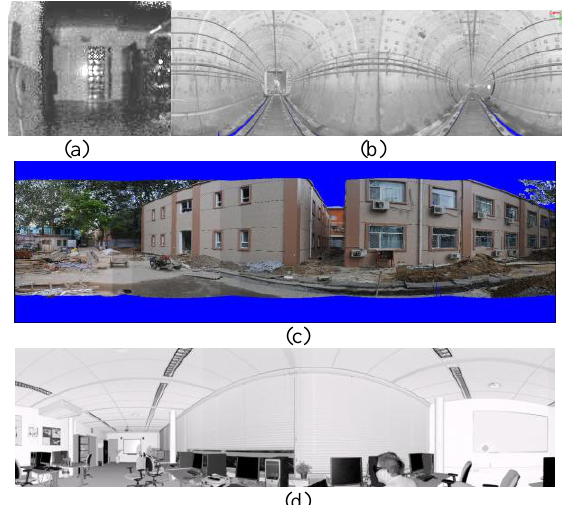
Figure 2. Experimental datasets visualized as panoramic 2D images. The grey values indicate intensity. (a) Dataset 1; (b) Dataset 2; (c) Dataset 3; (d) Dataset 4.